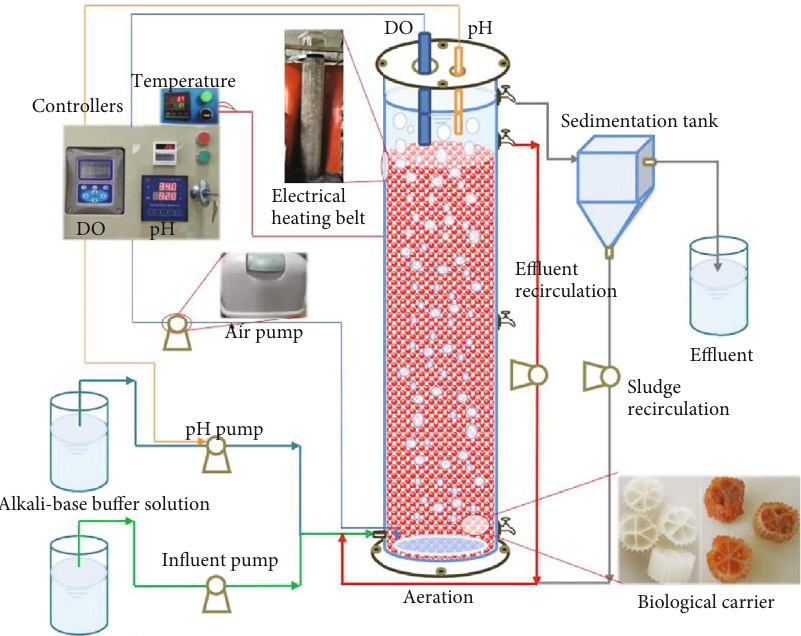
Figure 1: Schematic of the experimental device.